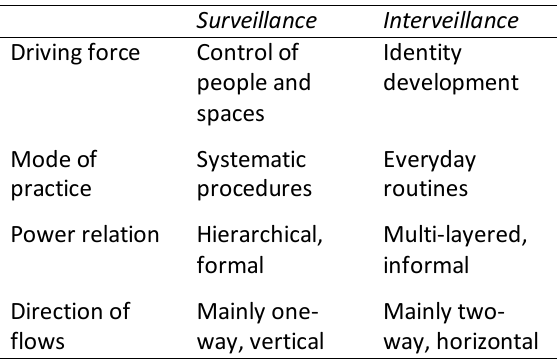
Table 1. Analytical distinctions between surveillance and